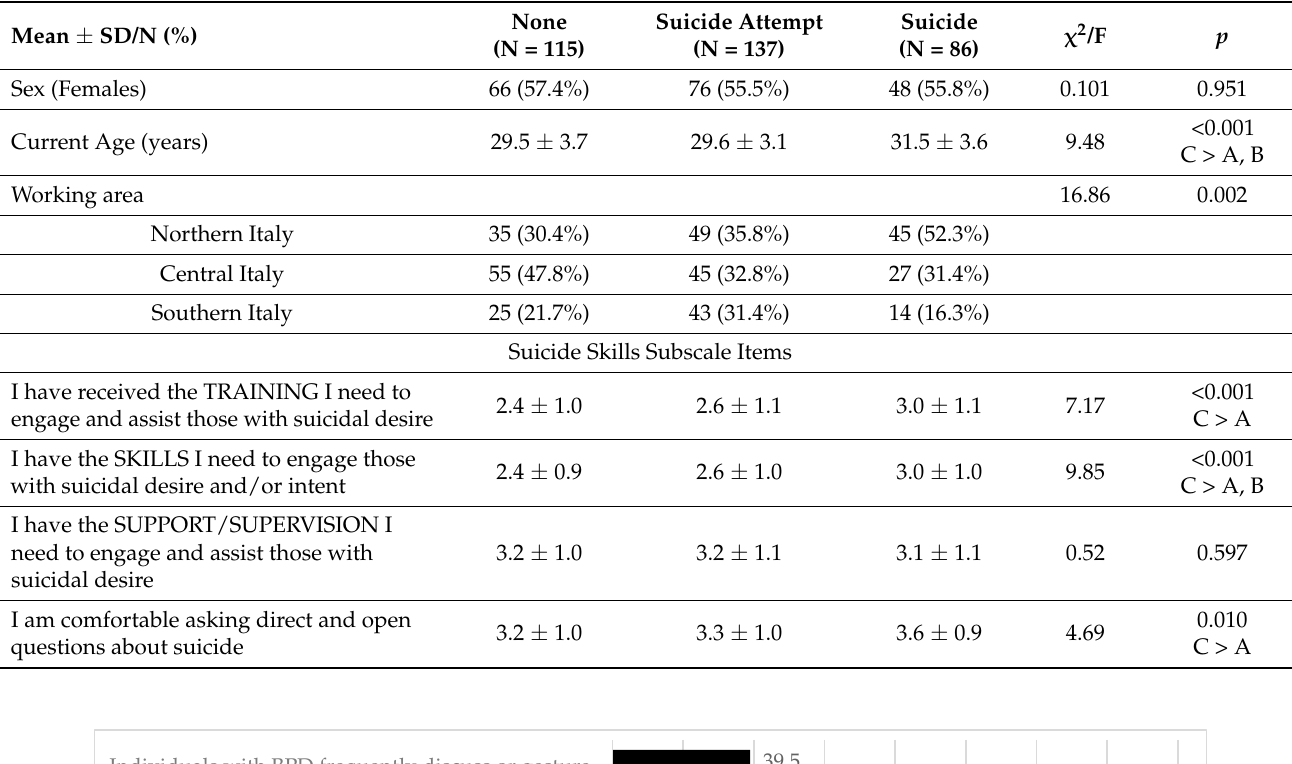
Table 3. Differences between subgroups according to the experience of patient’s suicide (general characteristics and suicide-skills-subscale items).